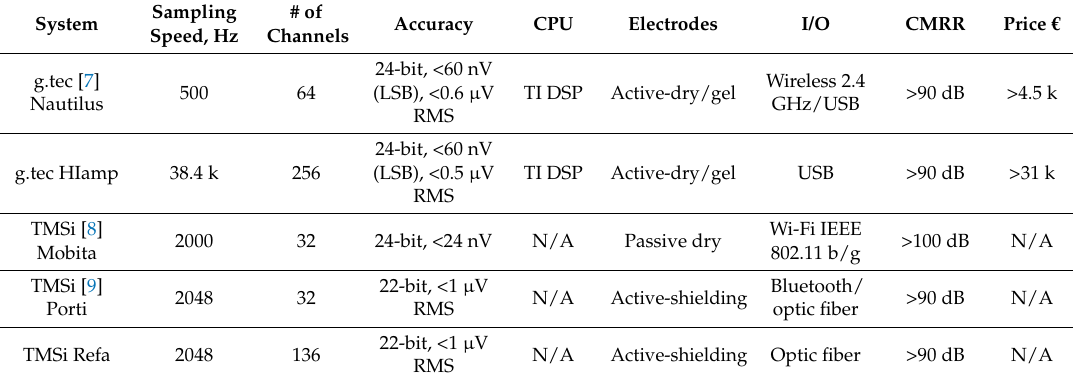
Table 1. State-of-the-art professional brain–computer interface (BCI)